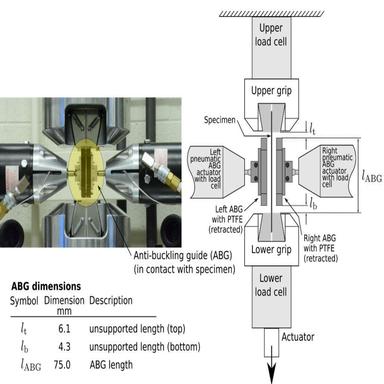
A close-up view of the tension-compression testing machine anti-buckling guides.